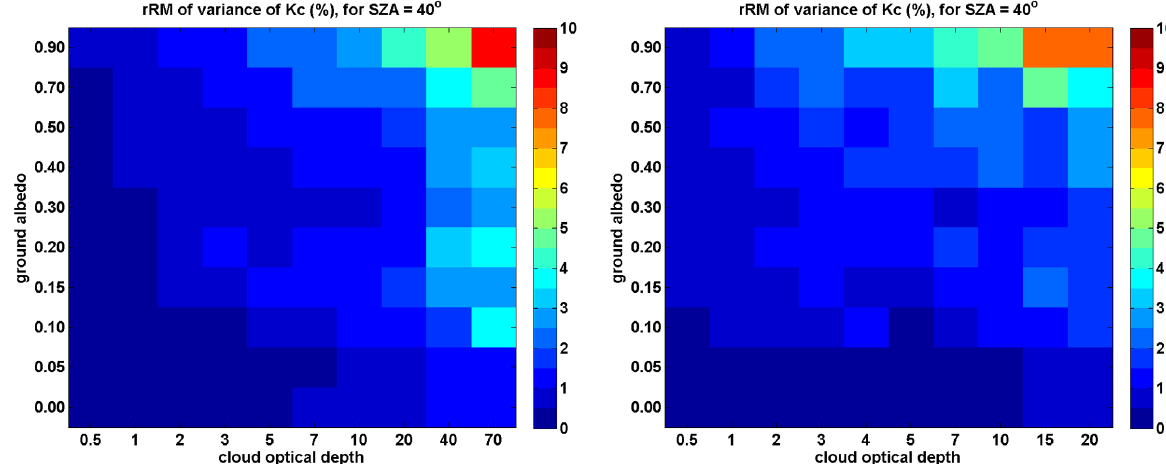
Figure 2. Relative root mean of variance of K c due to changes in P c as a function of ρ g and τ c for θ S = 40 ◦ , for water cloud (left) and ice cloud